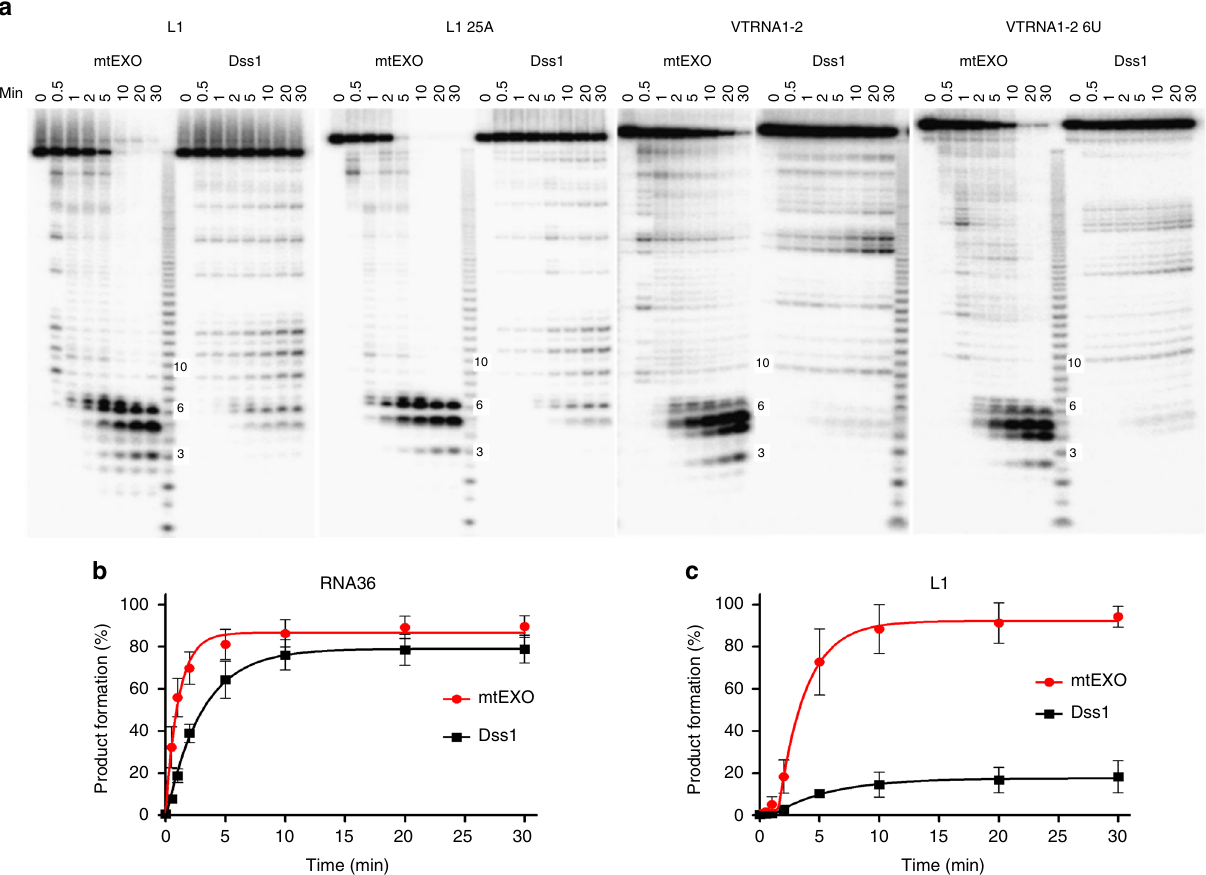
Fig. 5 Degradation of complex RNA structures by Cg -mtEXO and Cg -Dss1. a RNA degradation assay with structured RNA substrates (listed in Supplementary Fig. 10) for full-length Cg- mtEXO or Cg- Dss1. Degradation products were analyzed by 18% denaturing TBE-urea PAGE. b Plot of R36